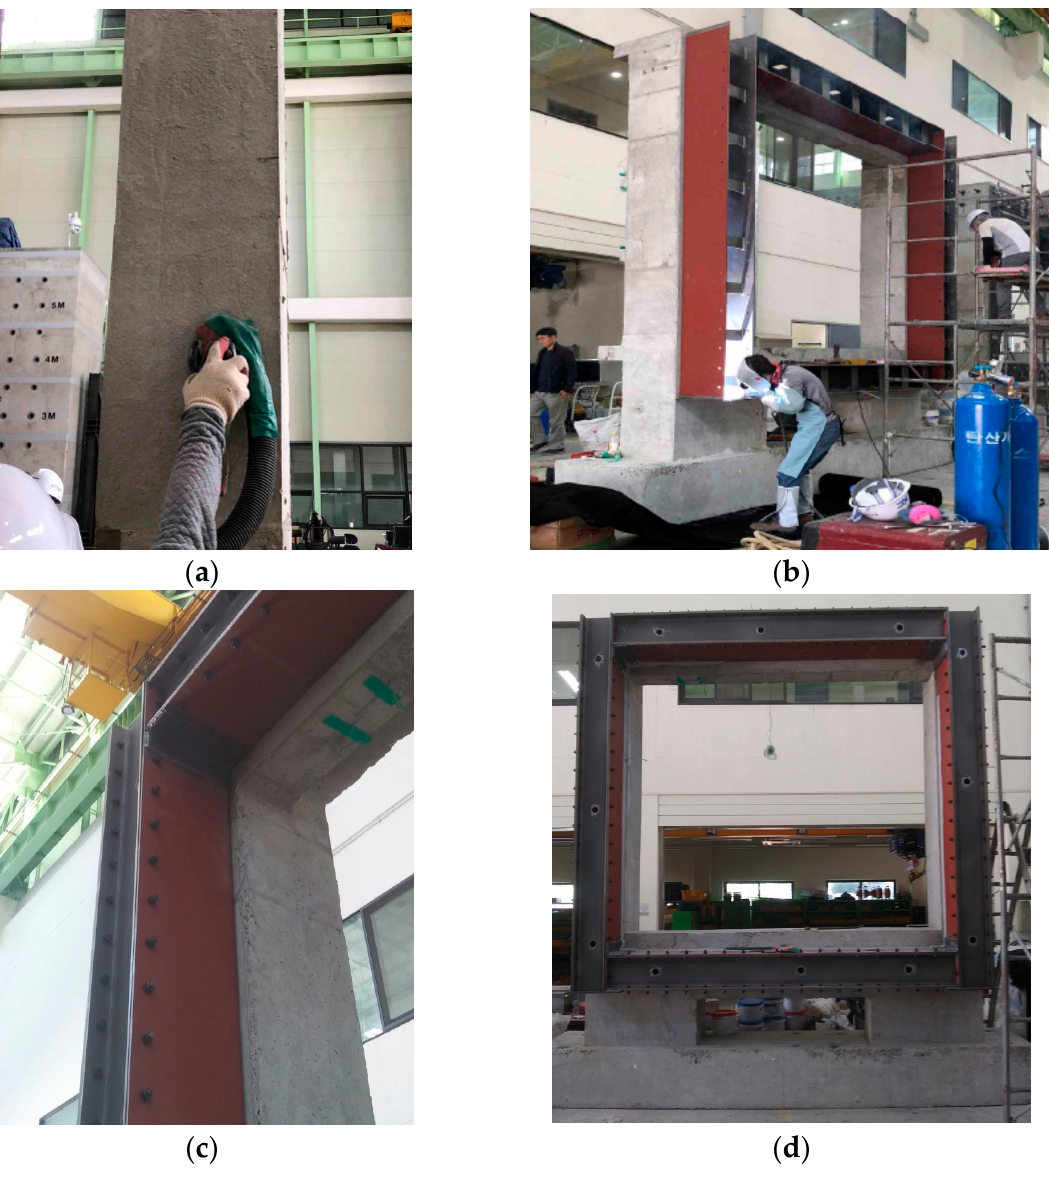
Figure 6. Process of attaching the CFST frame to the NoWS specimen: ( a ) Demolishing the finishing materials; ( b ) installation of the steel channel section; ( c ) bolting of the steel channel and cover; ( d ) injecting mortar into the steel channel.